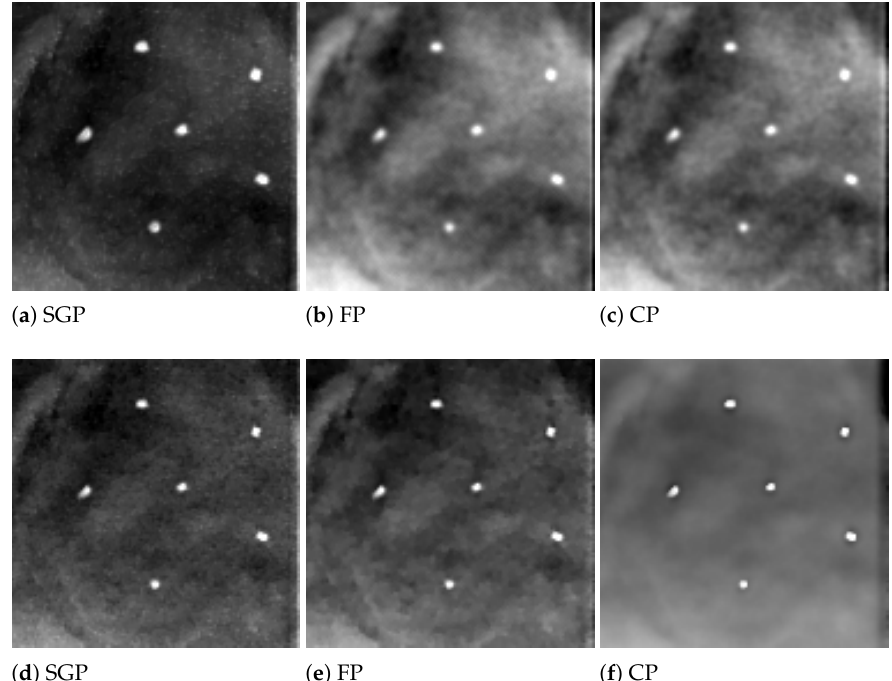
Figure 3. Reconstructions of microcalcification cluster number 3 in BR3D phantom obtained with Scaled Gradient Projection (SGP), Fixed Point (FP) and Chambolle–Pock (CP) methods. In the upper row, reconstructions in 5 iterations; in the bottom row, reconstructions in 15